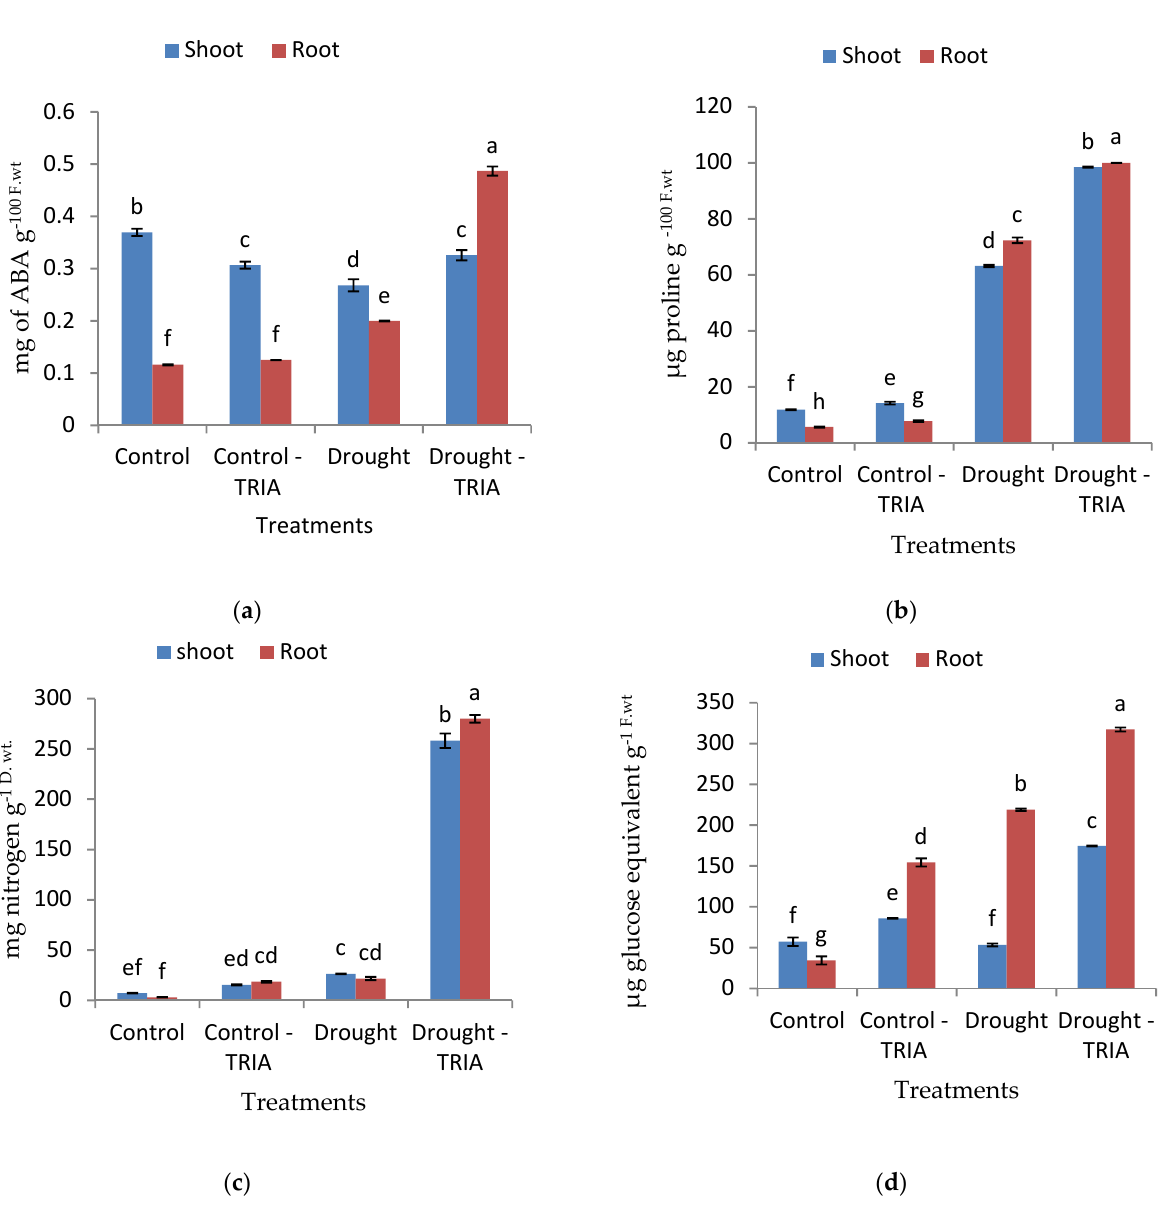
8 of 16 Figure 2. Effect of TRIA (35 ppm) treatment on percentage of stomatal openings on both the upper and lower surface of leaves of drought-stressed rice. Each value is the mean of three replicates ± SE. Columns with different letters are significantly different at p ≤ 0.05. The current data also revealed that exposure to drought stress significantly in- creased and decreased the ABA content of the roots and shoots, respectively (Figure 3a). In addition, proline and amino acids showed a significant increase in both the shoots and roots of drought-stressed seedlings as compared with the unstressed control (Figure 3b,c).